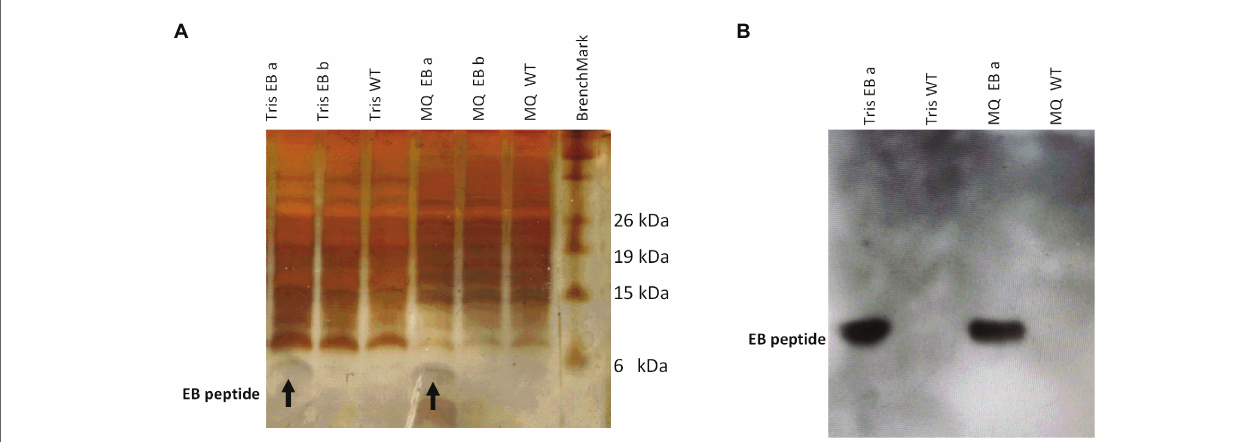
FIGURE 3 | Detection of an estimated 3.4-kDa band in transformed microalgae, corresponding to the EB peptide. (A) Protein electrophoresis from transformed and wild-type microalgae. The EB peptide (3.4 kDa estimated size) is observed in Tris and Milli Q water extracts from transformed microalgae lines EB a and EB b, respectively. (B) Western blot EB peptide detection with an anti-EB antibody in microalgae extracts. Tris and MQ water EB a line extracts from transformed microalgae are shown as well as Tris and MQ water WT from wild-type microalgae extracts. (MQ): Milli Q water.